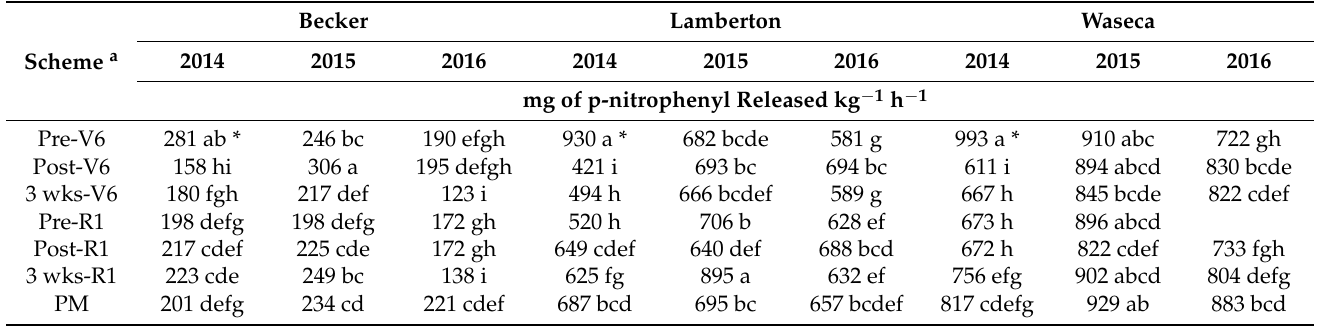
Table 5. In-season β -glucosidase activity across treatments at Becker, Lamberton, and Waseca from 2014 to